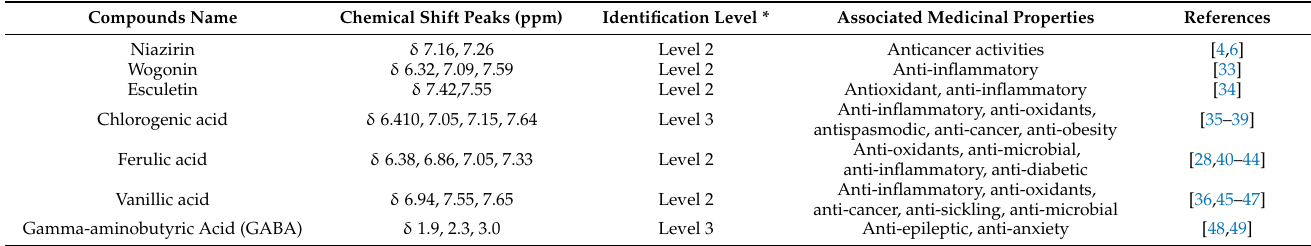
Table 2. Targeted metabolites that were annotated in the 1 H-NMR fingerprints. The NMR values obtained and the medicinal properties for each compound are